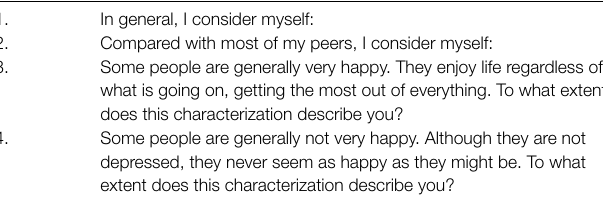
TABLE 2 | Subjective happiness scale by Lyubomirsky and Lepper (1999), translated and evaluated by Vera-Villarroel et al. (2011).